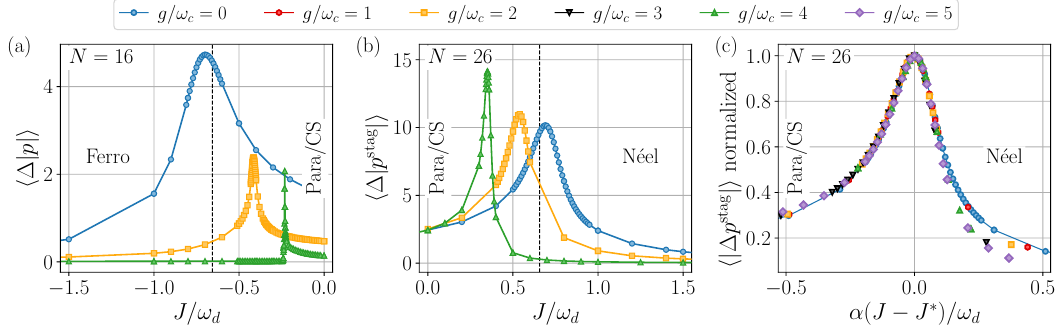
Figure 3: Order parameter fluctuations. Fluctuations for the phase transitions be- tween the disordered and (a) ferroelectric, (b) Néel phases as a function of the dipole-dipole interaction J /ω . The peaks are used to estimate the finite-size phase d boundaries J ∗ ( g /ω , N ) [ see also Fig. 2(a) ] . The dashed vertical lines indicate the c critical point J ∗ ( g = 0 ) in the thermodynamic limit N → ∞ [ 58 ] . With increasing coupling g /ω , we observe a cavity-induced reduction of | J ∗ | /ω and a narrowing of c d the critical region, which is estimated by the width of the peaks. (c) The fluctuations 〈| ∆ p stag |〉 normalized by the height of their peak are plotted against the rescaled dis- ) , where the rescale factor α depends on g /ω tance from the critical point J ∗ ( g /ω . c c We observe a good collapse with the fluctuations in the transverse field Ising limit = g /ω c